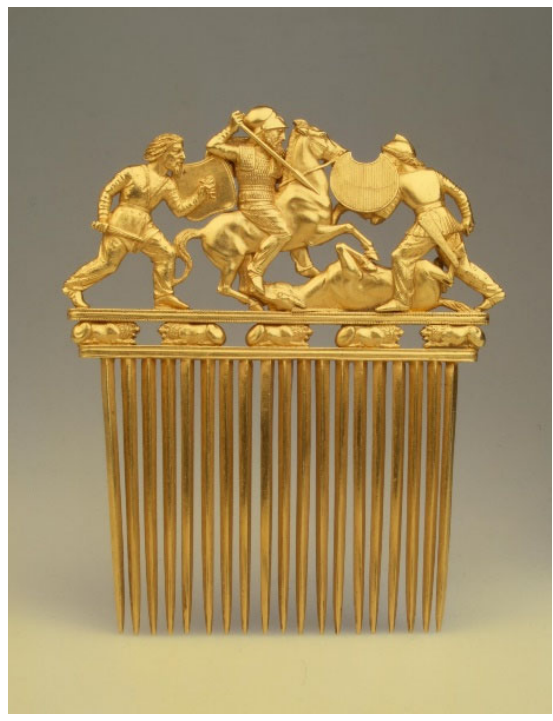
Figure 25. Comb with battle scene (SHM inv. no. Дн .1913 ‐ 1/1); gold; Solokha Tumulus,